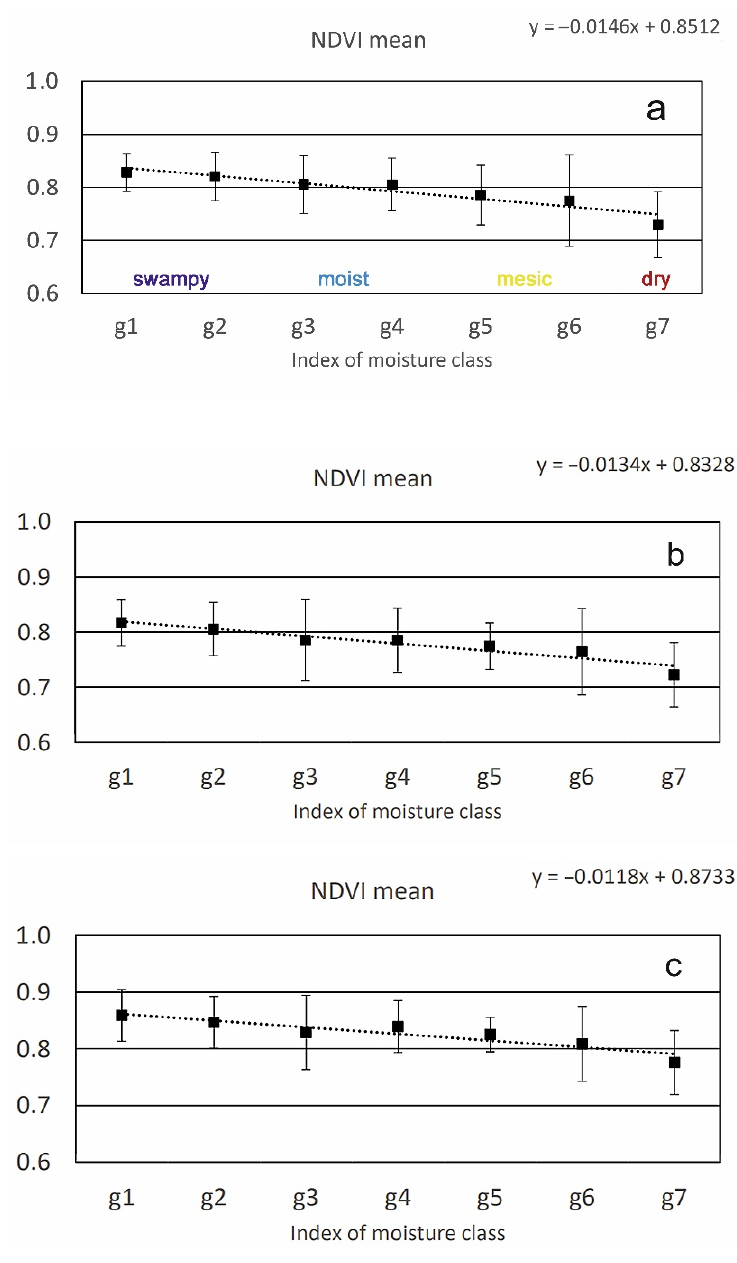
Figure 4. ( a ) Mean NDVI value from the Sentinel 2 image obtained on 20 July 2018, taking into account all FHMIs (g1–g7). ( b ) Mean NDVI value from the Sentinel 2 image obtained on 30 July 2019,